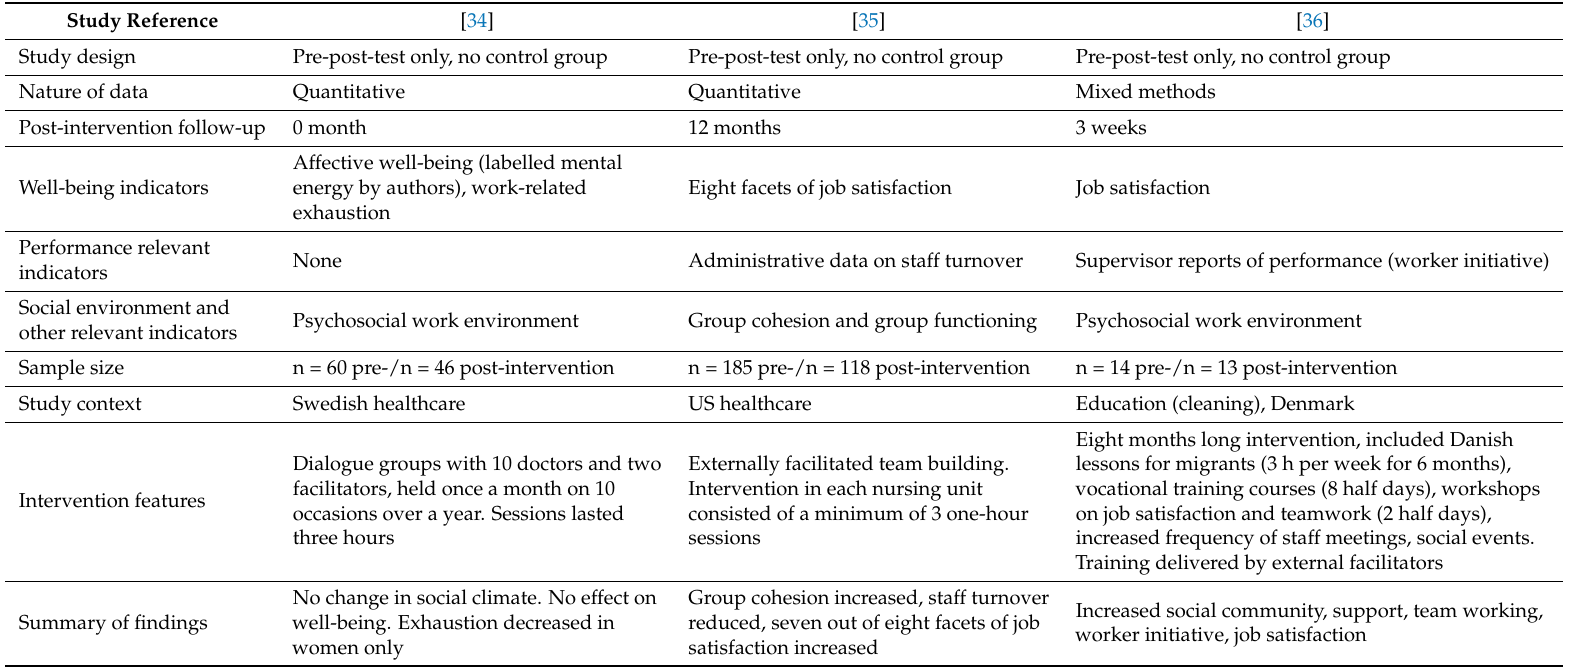
Table 1. Summary of studies on shared social